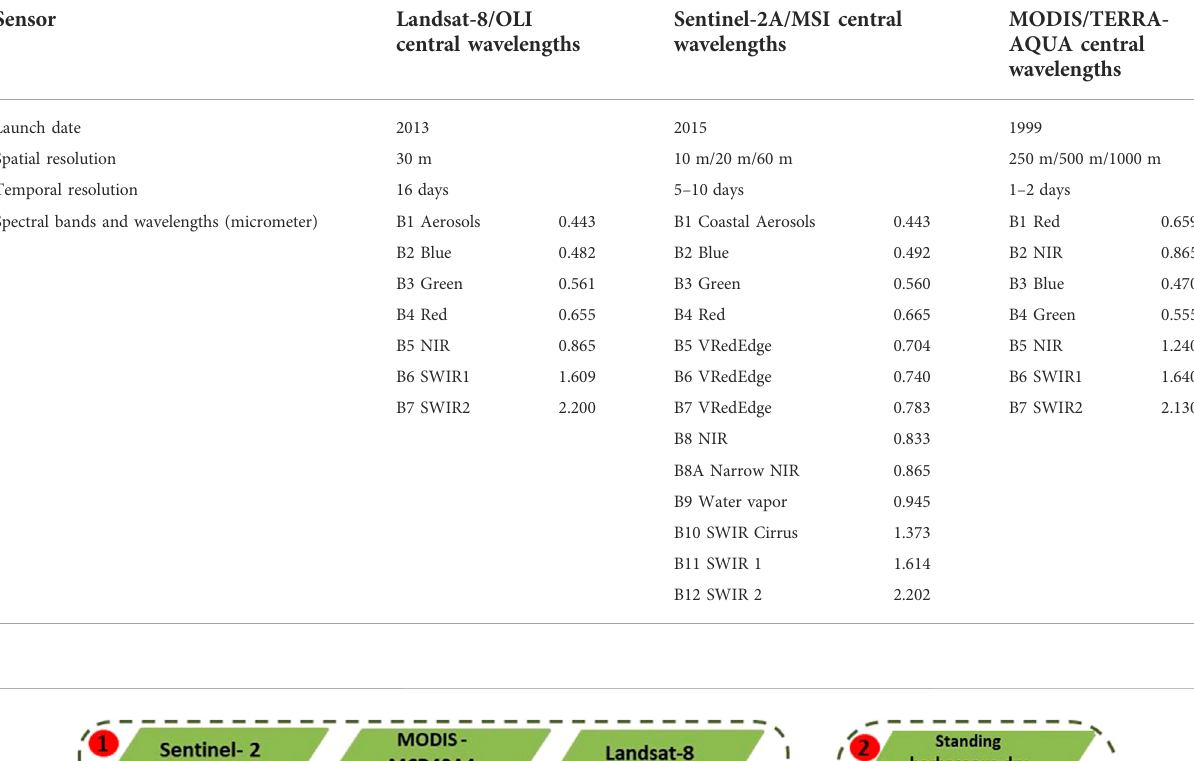
TABLE 1 Description of the sensors used in the study.